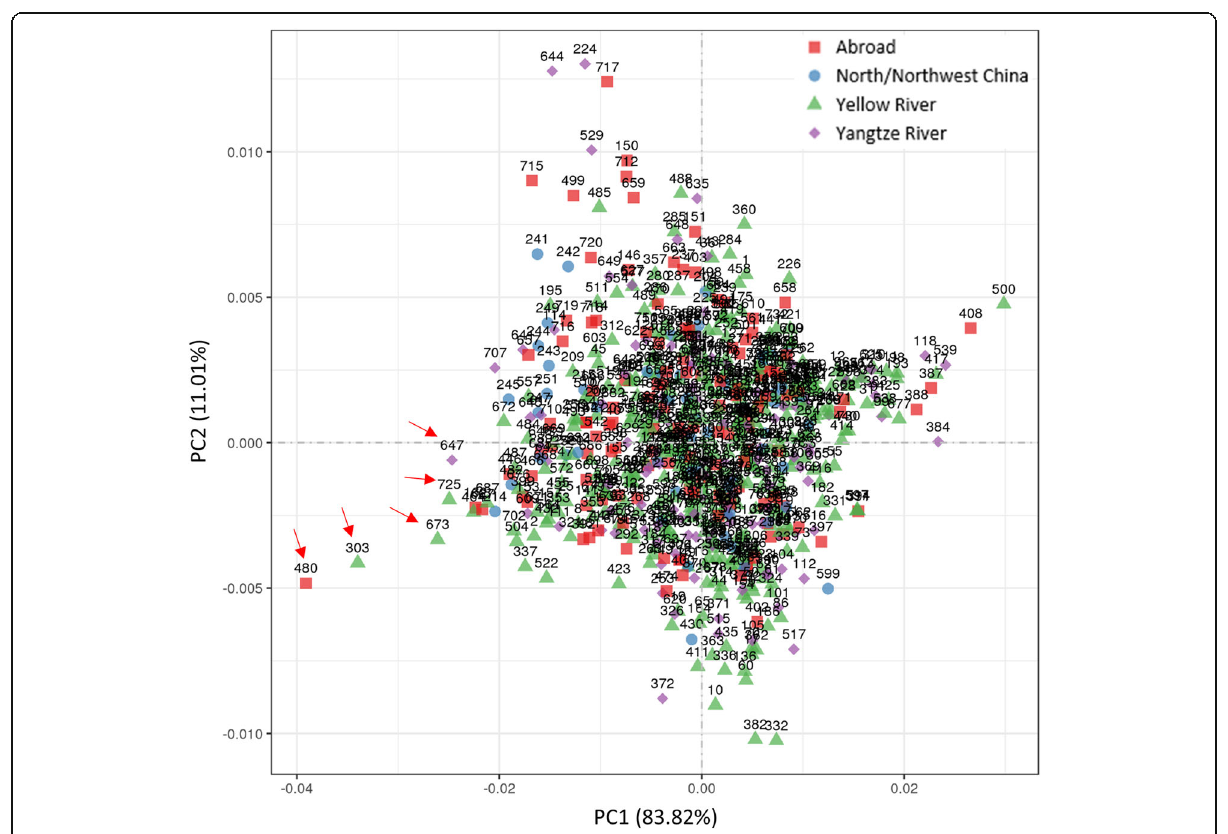
Fig. 3 PCA for 719 upland cotton accessions based on the mean values of five fibre quality